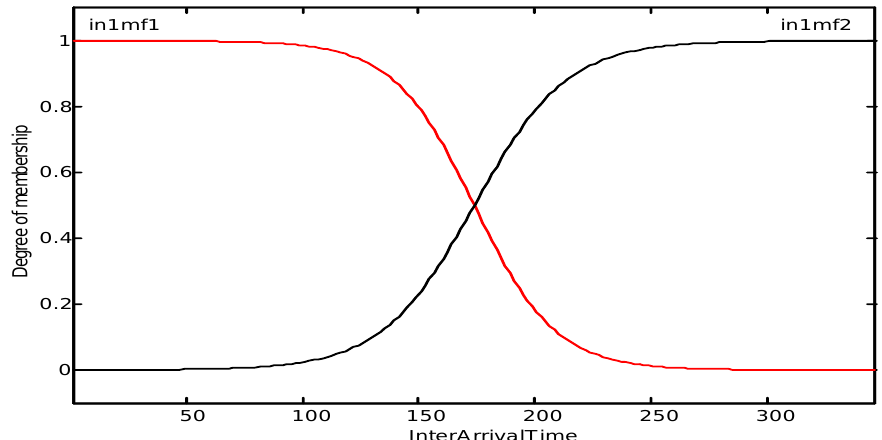
Figure 8. Fuzzy functions of membership for the input variable of inter-arrival time. The values of the prediction of time spent in the system, based on the input values of checking data of the selected model, are given in Table 7. Table 7. The values of the prediction of the time spent in the system and checking data.